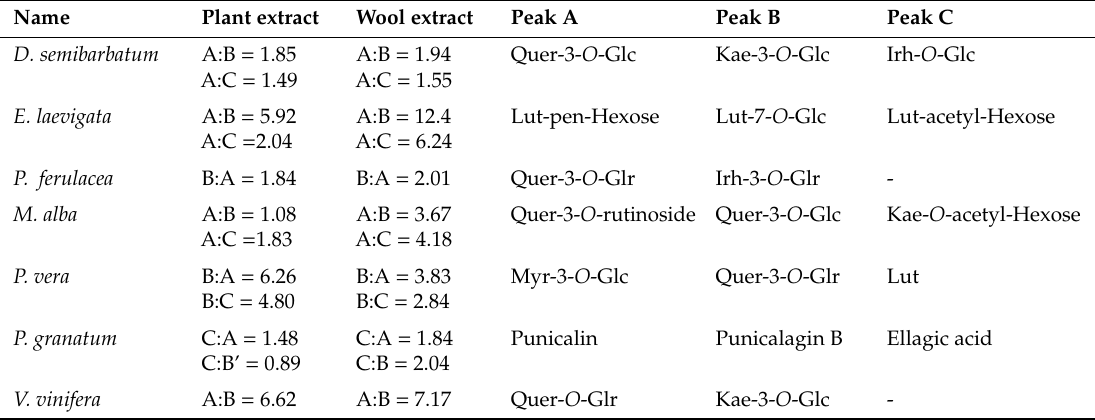
Table 5. Comparison of the main chromophores 1 extracted from the plants and the dyed wool: the ratios were obtained by normalizing the areas of the main chromophores, A B C, by the main peak in the chromatogram (HPLC-DAD). For more details, please see Table